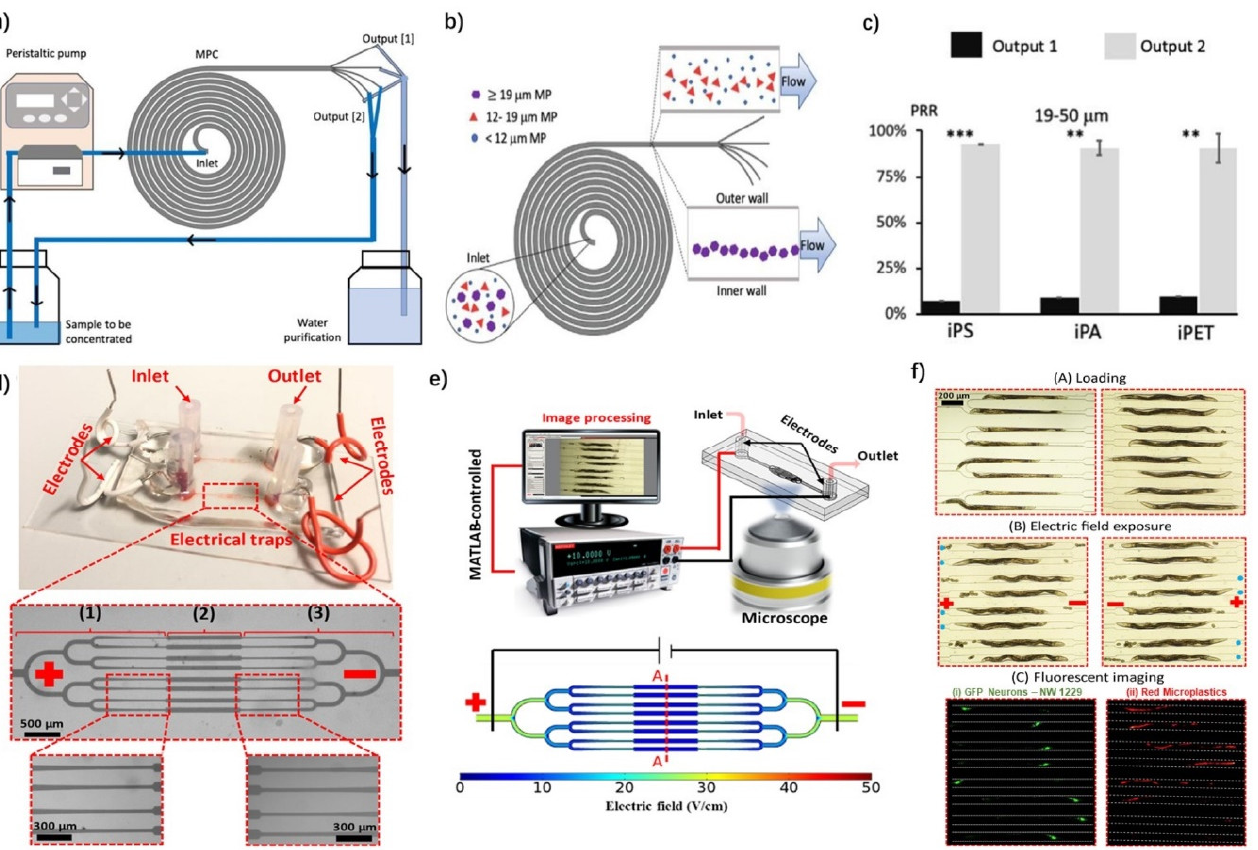
Figure 4. Illustration of the acoustic focusing separation method and a demonstration of its results. ( a ) A feedback loop system is integrated into the microfluidic system for continuous concentration and purification of MPs. ( b ) MPs are separated and collected according to their size differences. ( c ) High-yield separation and collection of PS, PA, and PET with diameters between 19 and 50 µm was achieved. Reprinted with permission from [10]. Copyright 2022, Elsevier. ( d ) A microfluidic system was designed with 8 channels for the investigation of the effect of MPs on the egg-laying of worms. ( e ) The system incorporated an inverted microscope for real-time monitoring. ( f ) The experimental process was demonstrated, and fluorescence imaging (green: GFP neurons and NW1229 worms; red: worms that had ingested MPs) was utilized. Reprinted with permission from [76]. Copyright 2021, Elsevier.